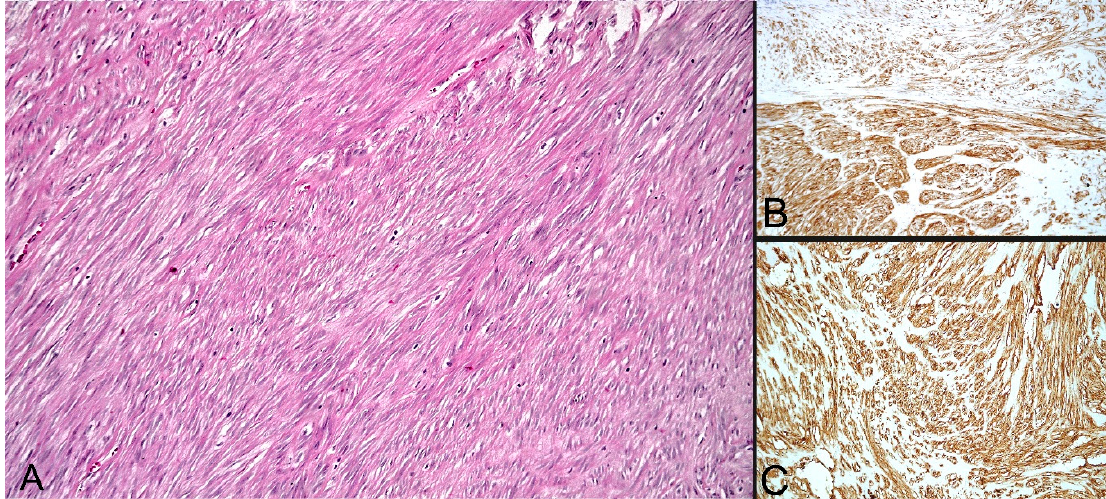
Figure 4. ( A ) HE stain of the gastro-intestinal stromal tumor with intertwining broad fascicles of spindle cells (×200). ( B ) IHC positivity for c-KIT (CD117) (×200). ( C ) CD34 IHC positivity (×200).